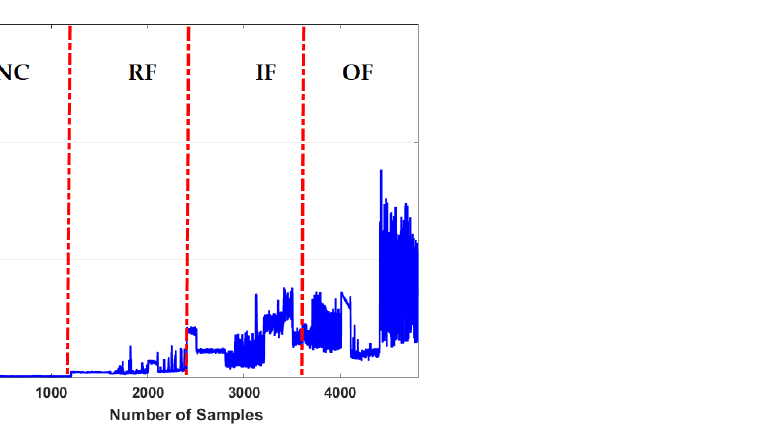
Figure 9. The average accuracies of crack identification using the MGPRLF-RPI+SVM technique. Figure 10 shows the residual signal for the MGPRLF-PI technique. Based on the com- parison of Figures 6, 8, and 10, the accuracy of fault pattern recognition (especially for IF and OF) using proposed ADT approach is better than MGPRLF-RPI and MGPRLF-PI methods.